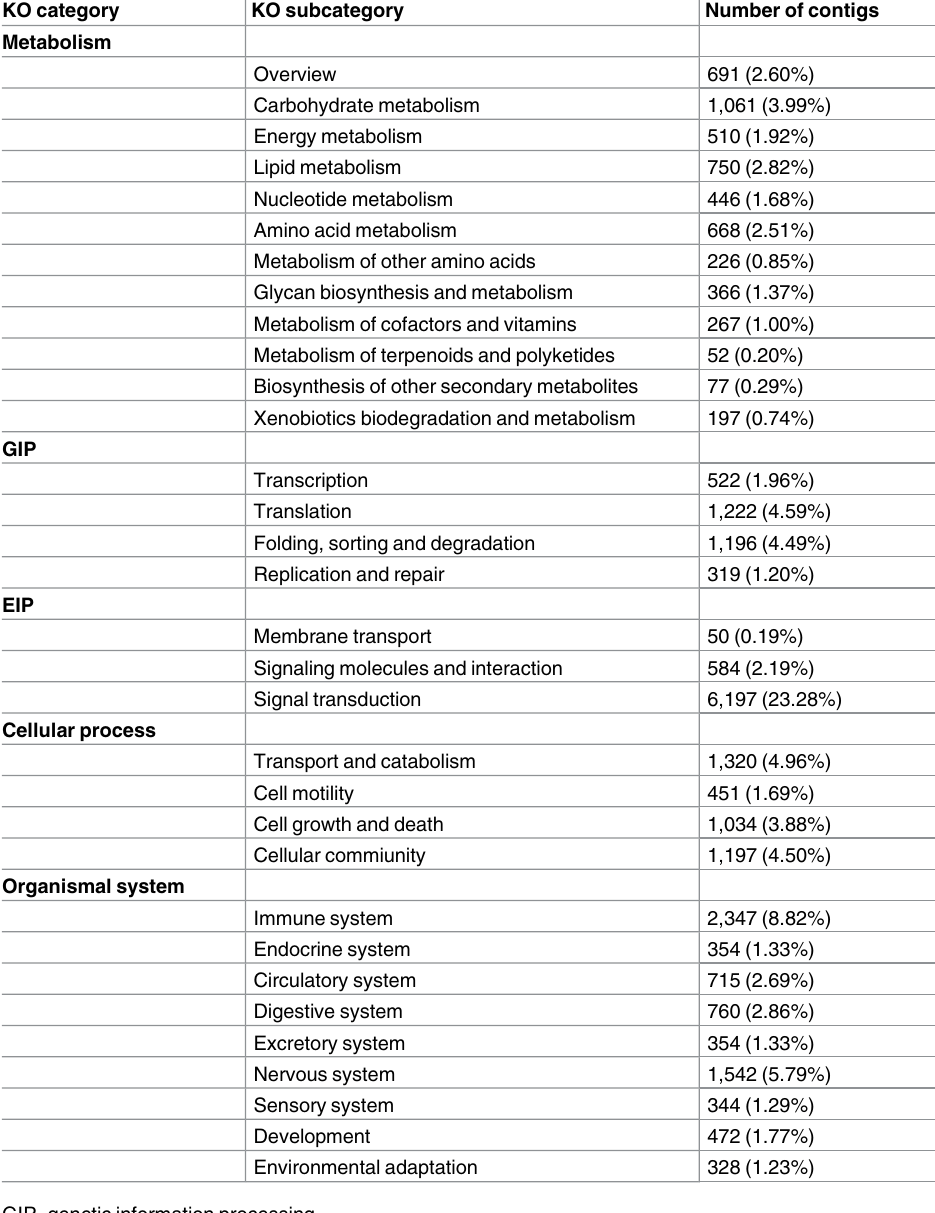
Table 3. KEGG analysis of the sea trout skin